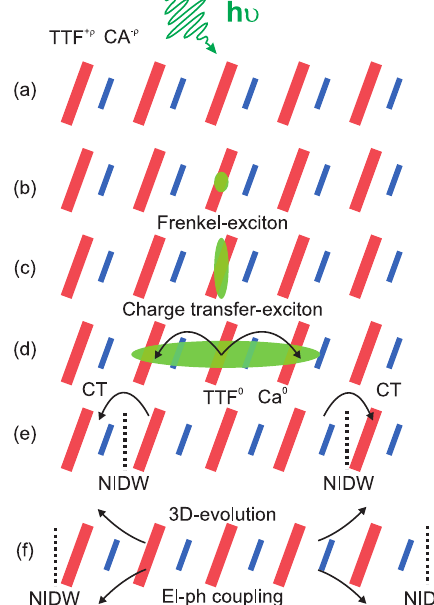
Figure 21. ( a ) Illustration of a one-dimensional chain of dimerized TTF + ρ and CA + ρ pairs in the ionic phase in TTF-CA. TTF + ρ molecules are excited with a laser pulse of the photon energy E Photon = h ν ; ( b ) Vertical excitation of the HOMOs of TTF + ρ according to the Franck–Condon-principle in the LUMO of TTF + ρ . The excitation is strongly localized on the molecule; ( c ) Creation of excitons, for instance Frenkel-excitons, which are delocalized across the whole molecules; ( d ) Via different relaxation processes and channels, charge-transfer excitons are created that trigger the transition of the neutral phase; ( e ) The dimerization is suppressed and the charge between the molecules is redistributed. A neutral domain is created in the ionic host matrix, which is separated by NIDWs; ( f ) Afterwards, the neutral domains extend along the one-dimensional chain. By electron-phonon-coupling, neighboring ionic chains are also converted into neutral regions and a three-dimensional domain is